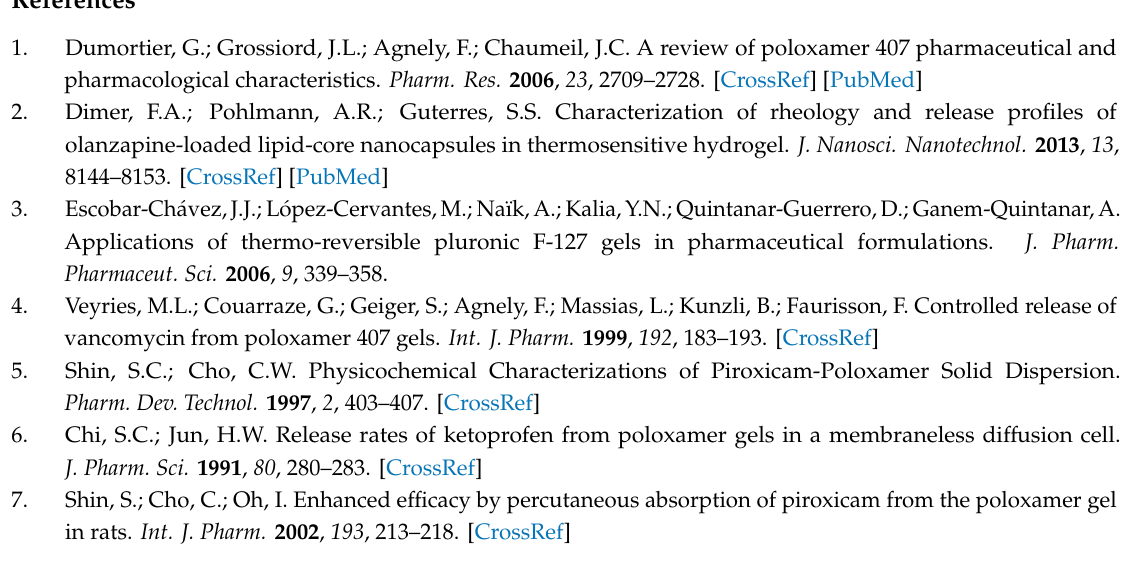
Supplementary Materials: The following are available online: Figure S1: Mean square displacement MSD for 25% Poloxamer 407 gel without carriers (A), or with ethosomes (B), transfersomes (C) and niosomes (D) as a function of correlation. The illustrated results are one of the parallel experiments. Figure S2: Elasticity Index (EI) and Solid Liquid Balance profile versus time for 25% (w / w) Poloxamer 470 with and without TDDSs. Figure S3: Mean square displacement MSD for 30% Poloxamer 407 gel without carriers (A), or with ethosomes (B), transfersomes (C) and niosomes (D) as a function of correlation. The illustrated results are one of the parallel experiments. Figure S4: Elasticity Index (EI) and Solid Liquid Balance profile versus time for 30% (w / w) Poloxamer 470 with and without TDDSs. Table S1 Gelation temperature of Poloxamer 407 solutions. Each value represents the mean ± S.D. of three